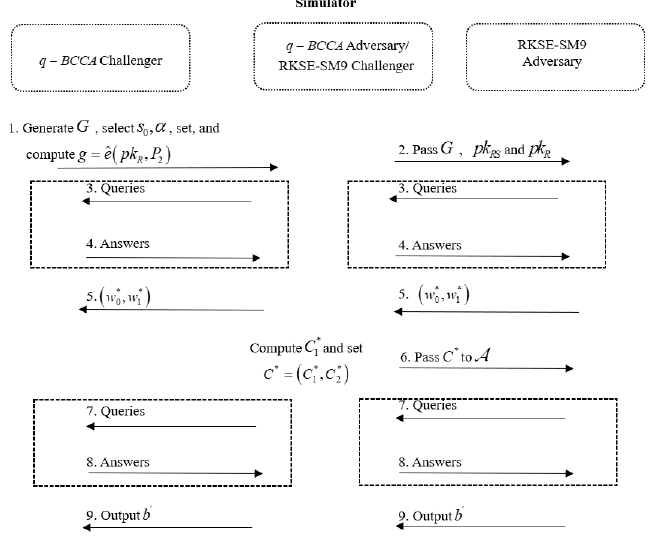
Figure 3. Security